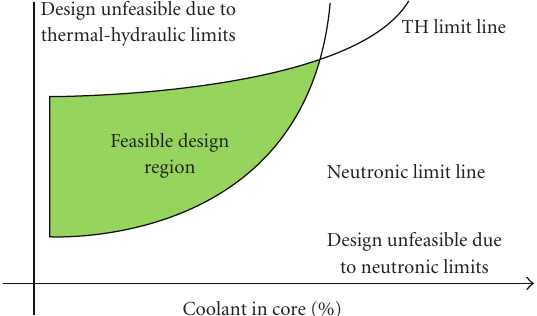
Figure 6: Schematic illustration showing a region of feasible GCFR designs bounded by neutronic and thermohydraulic (TH) limits.